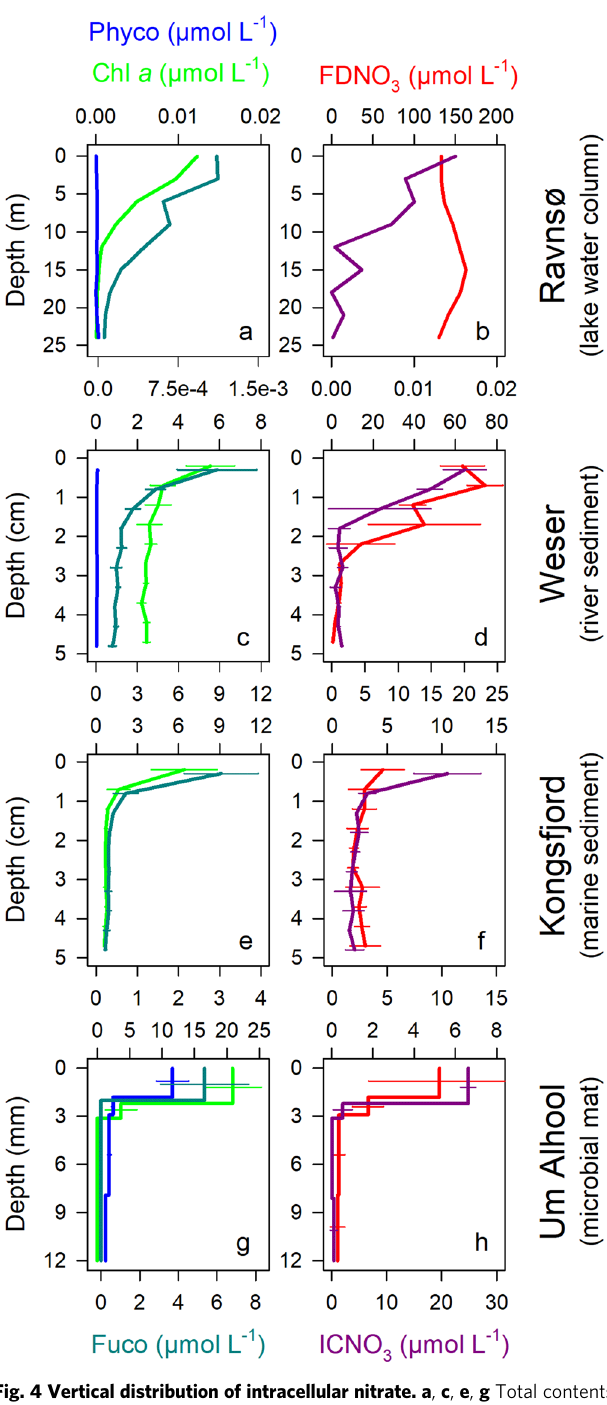
Fig. 4 Vertical distribution of intracellular nitrate. a , c , e , g Total contents of chlorophyll a (Chl a ), fucoxanthin (Fuco), and phycocyanin (Phyco) (a cyanobacteria marker pigment) and b , d , f , h freely dissolved nitrate (FDNO 3 ) and intracellular nitrate (ICNO 3 ) in one lake water column, two sediments, and one microbial mat. For sediments and microbial mats, FDNO 3 refers to porewater nitrate. For Kongsfjord, no phycocyanin data are available. Note that y -axes have meter, centimeter, and millimeter scales for water column, sediment, and microbial mat, respectively. Means ± standard deviation of n = 3 are shown; for better visibility, vertical sampling points are slightly offset. Vertical pro fi les for twelve additional sampling sites are shown in Supplementary Fig.